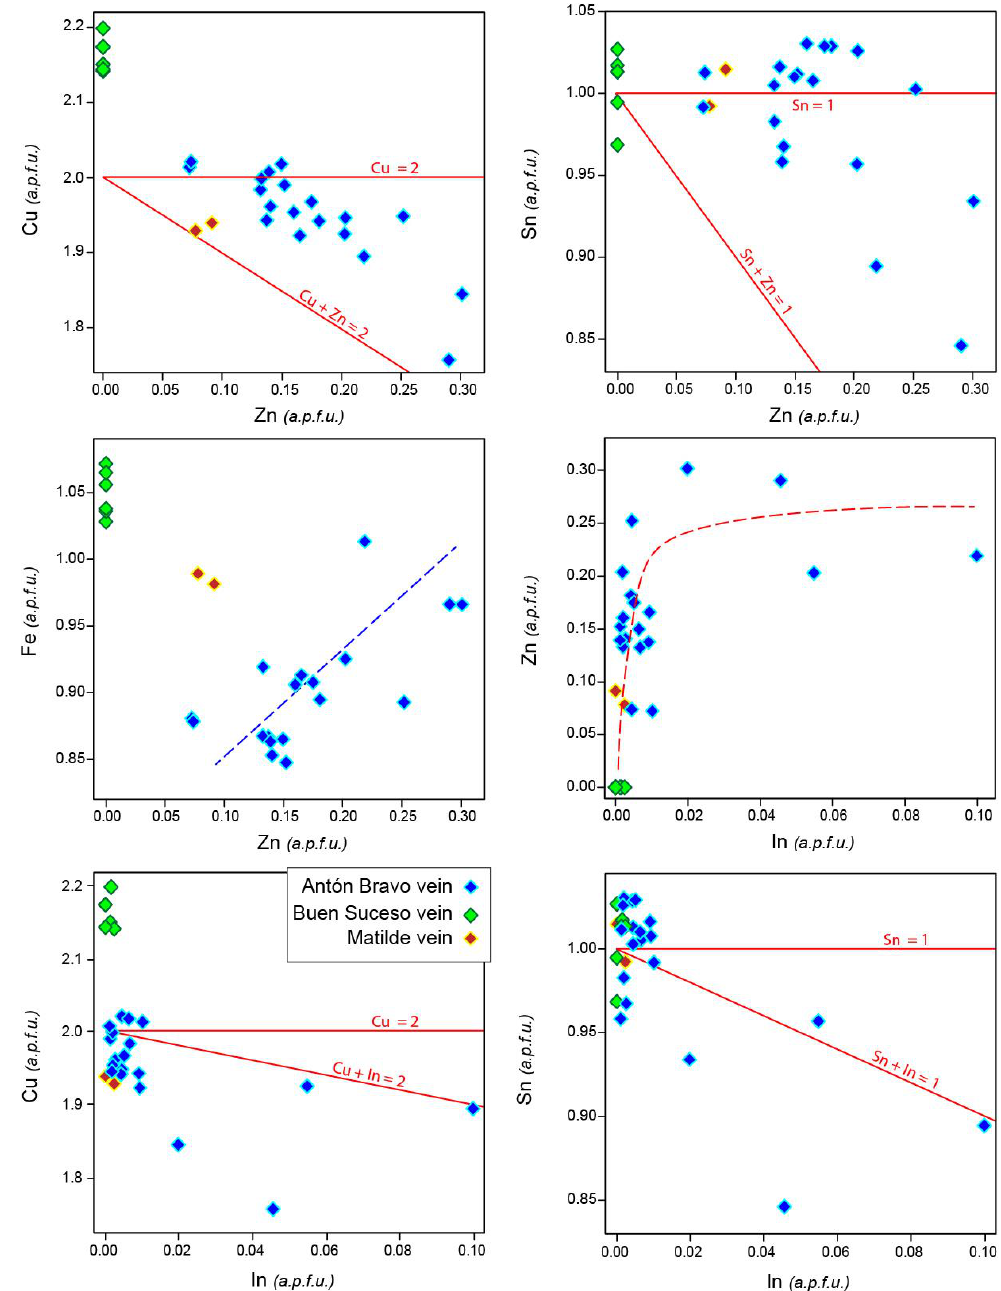
Figure 11. Correlation between elements in stannite from the Huari Huari district.